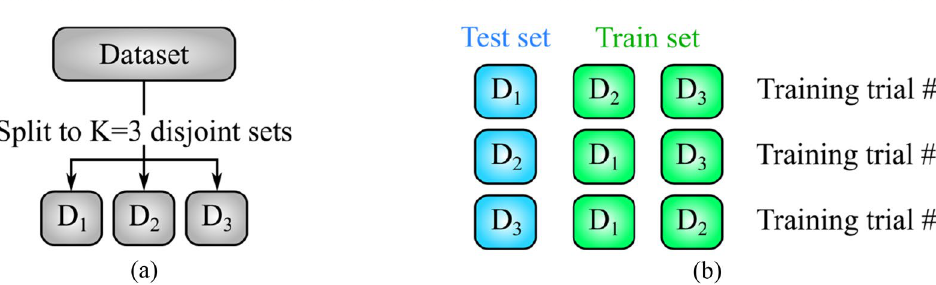
Figure 6. Graphical representation of threefold cross-validation: (a) dataset is partitioned into K = 3 disjoint subsets { D 1 , D 2 , D 3 } , and (b) K = 3 training trials. In each trial, one of D 1 , D 2 orD 3 is used as the test